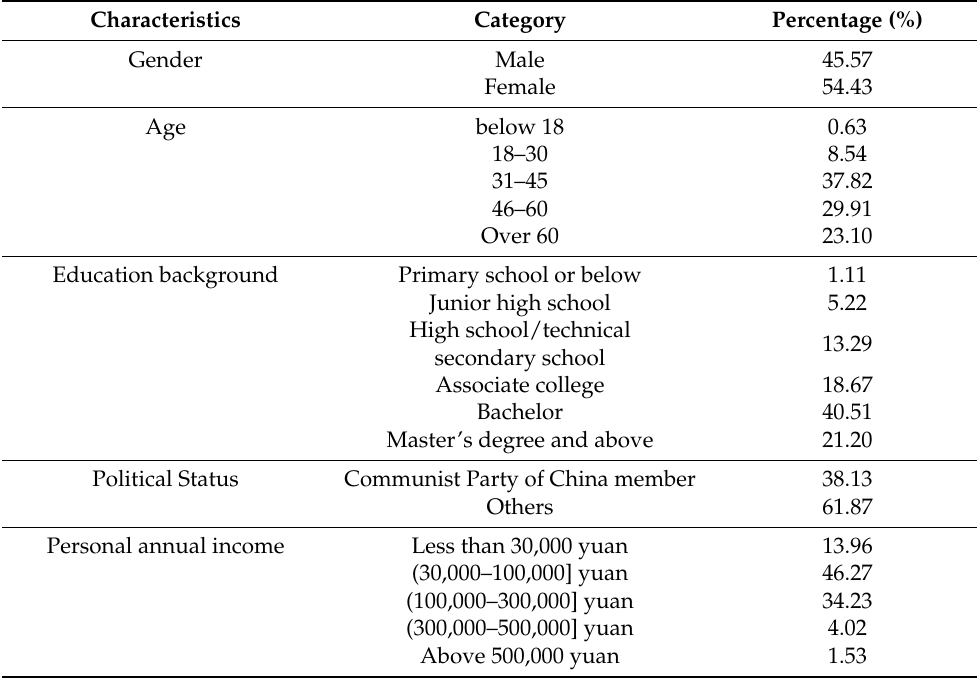
Table 1. Basic characteristics of the questionnaire